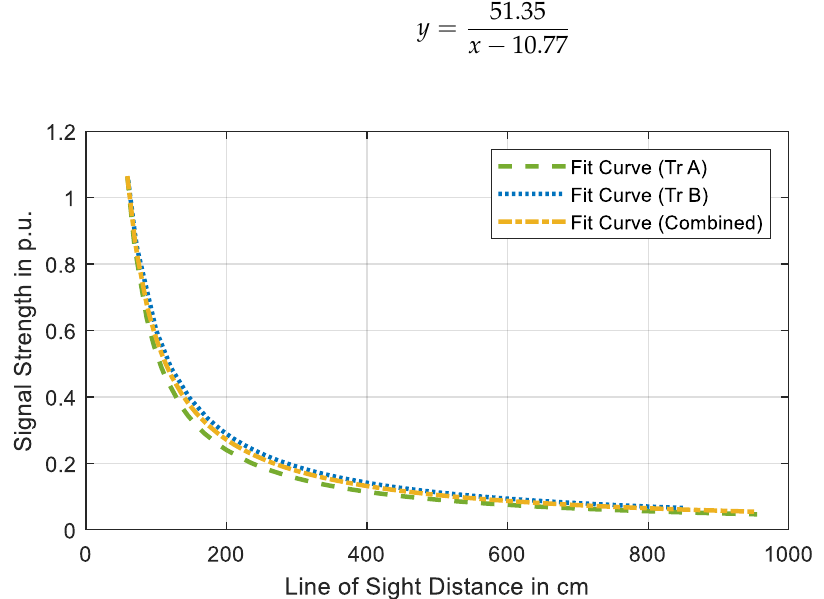
Figure 7. Comparison of the fit curves of transformers A, B, and the combined dataset.